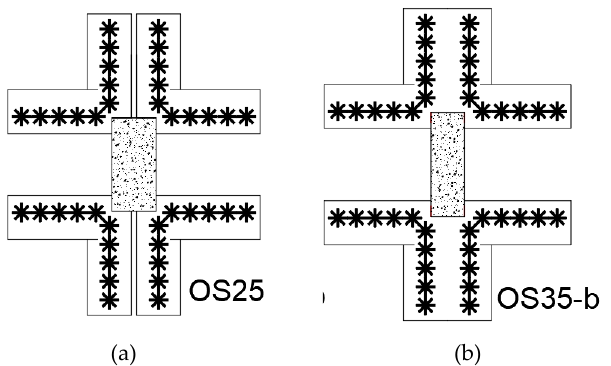
Figure 9. CFRP vertical reinforcement orthogonal to column orientation five rows with ( a ) column aspect ratio of 2.0 (OS25) and ( b ) a column aspect ratio of 3.0 [34].